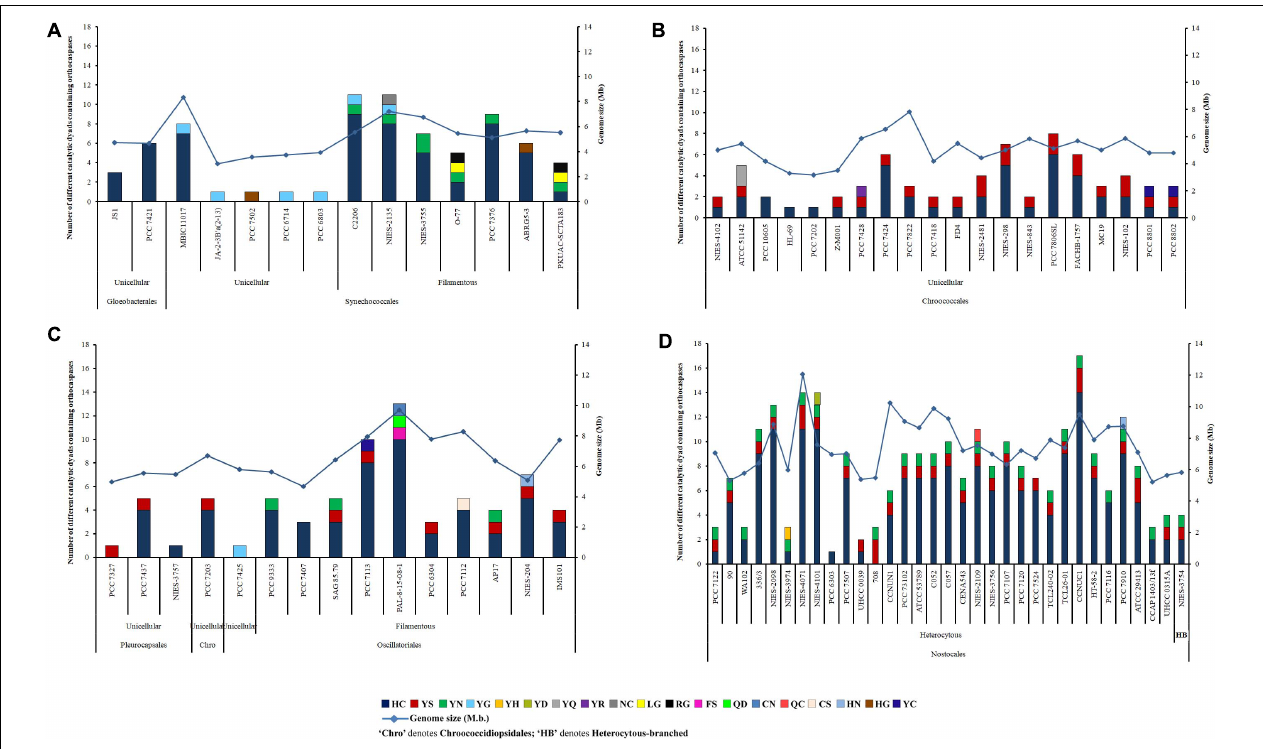
FIGURE 1 | Abundance, distribution, diversity of putative cyanobacterial orthocaspases among (A) Gloeobacteriales, Synechococcales, (B) Chroococcales, (C) Pleurocapsales, Chroococcidiopsidales, Oscillatoriales, and (D) Nostocales. Cyanobacterial strains subsumed within different taxonomical orders are also categorized into unicellular, filamentous, and heterocytous branches based on their morphology. The full forms of the abbreviated strain names are mentioned in Supplementary Table 4 .